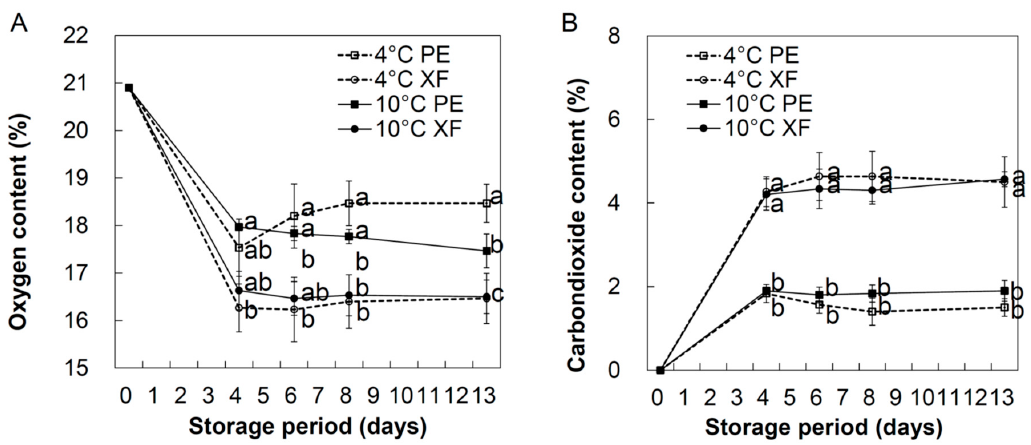
Figure 1. Oxygen ( A ) and carbon dioxide ( B ) concentration inside the “box-in-bag” packaging of oriental melons. The melons were packaged using polyethylene film (PE) or Xtend film (XF) and stored at 4 °C and 10 °C for 14 days. Data are presented as the mean ± SE of three replicates. Different letters indicate significant difference among treatments within the same storage temperature and storage time by Tukey’s HSD test with p <